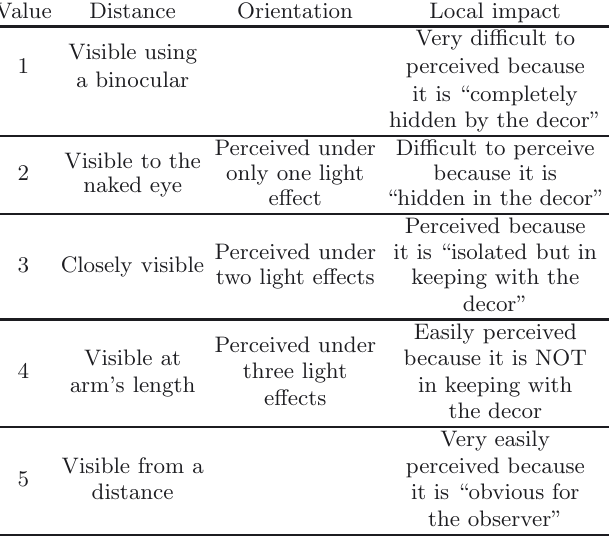
Table 3. The possible attribute values.